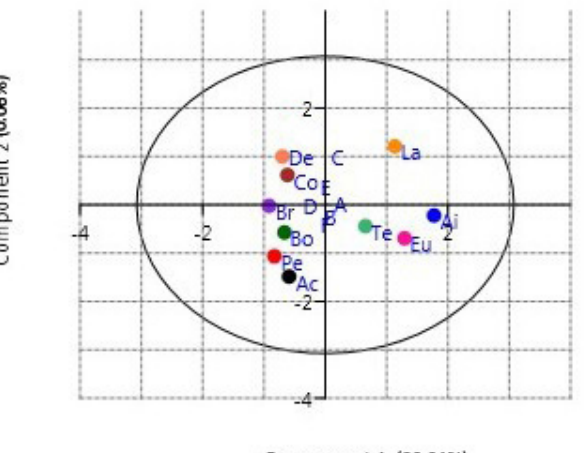
Fig 5 . PCA chart showing difference between body surface pollen content and floral characteristics. Ac = Acacia auriculiformis , Bo = Borassus flabellifer , Br = Brassica juncea , Co = Cocos nucifera , De = Delonix regia , Eu = Eucalyptus tereticornis , La = Lannea coromandelica , Pe = Peltophorum pterocarpum , Te = Tectona grandis ; A = body surface pollen contents, B = Flower size, C = Flower shape, D = pollen presentation, E = pollen yield per flower, F = pollen